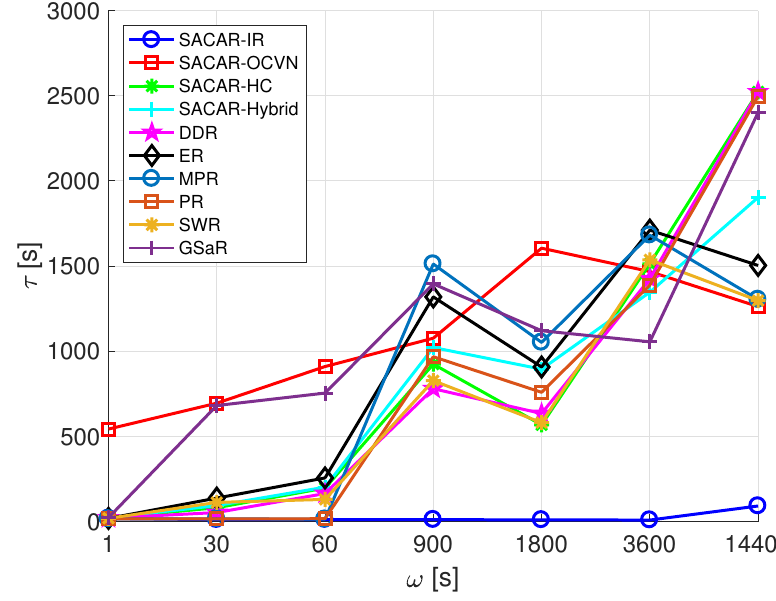
Figure 10. Average latency ( τ ) vs. frequency of message generation ( ω ): smart office scenario.